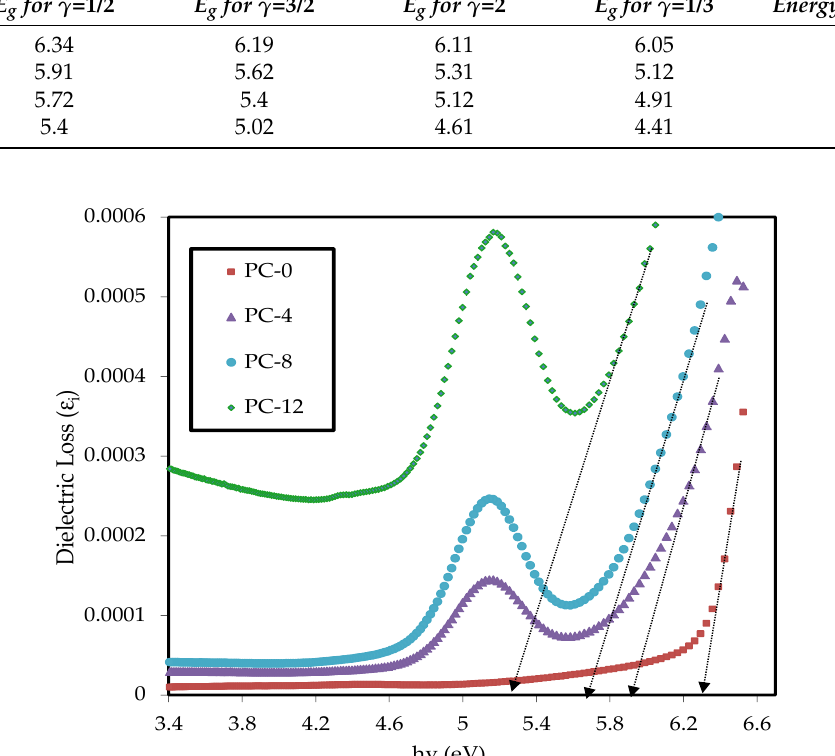
Figure 9. Dielectric losses vs. h υ for PVA and doped systems.